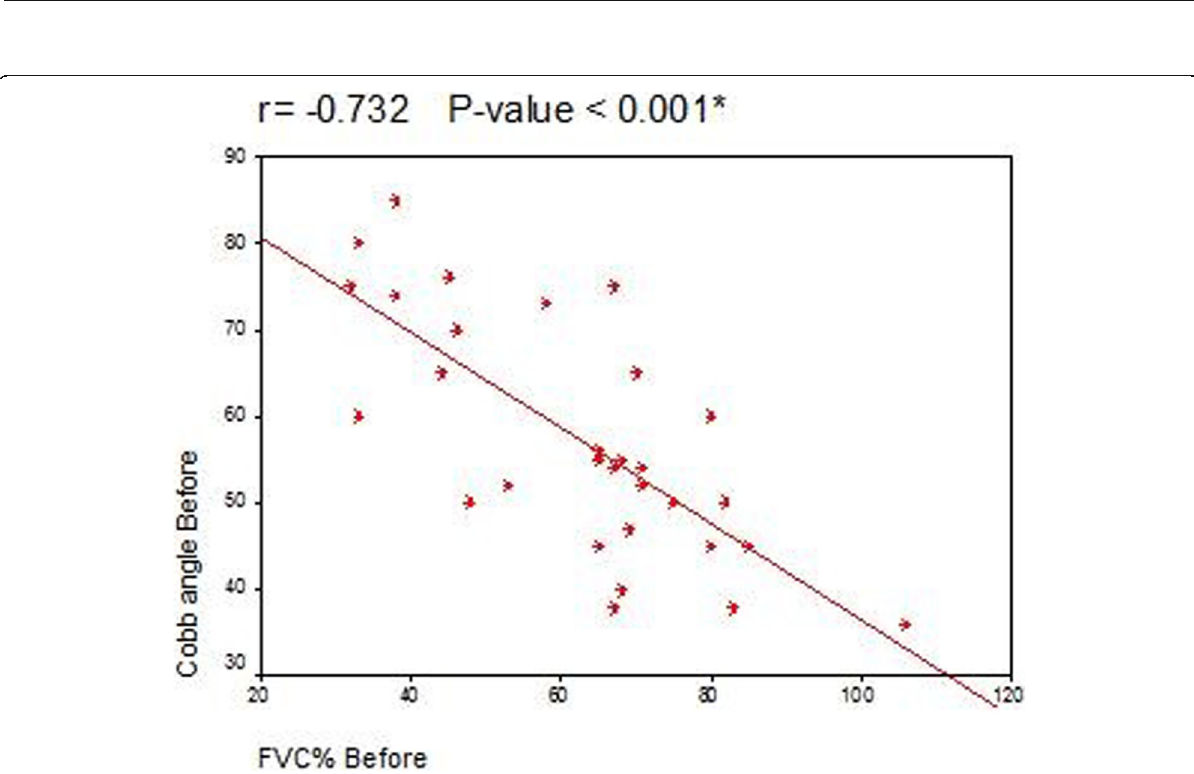
Fig. 2 Correlation between Cobb ’ s angle and FVC before operation. Pearson correlation coefficient, the sign before “ r ” denotes the direction of relation, P < 0.05 considered significant